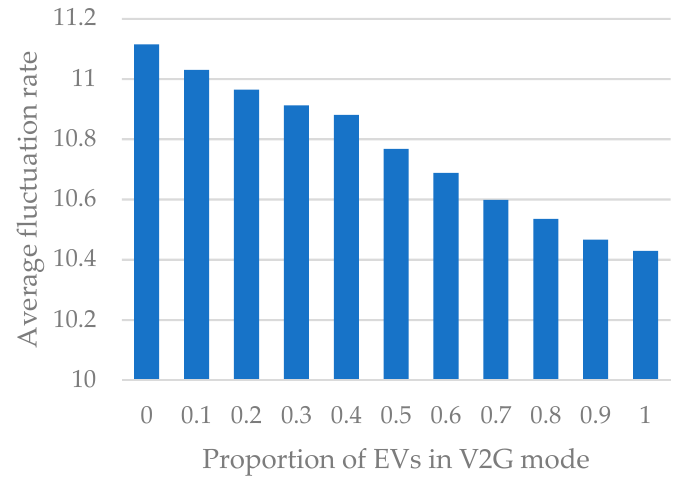
Figure 14. The average fluctuation rate of total load under different proportions of the EVs in V2G